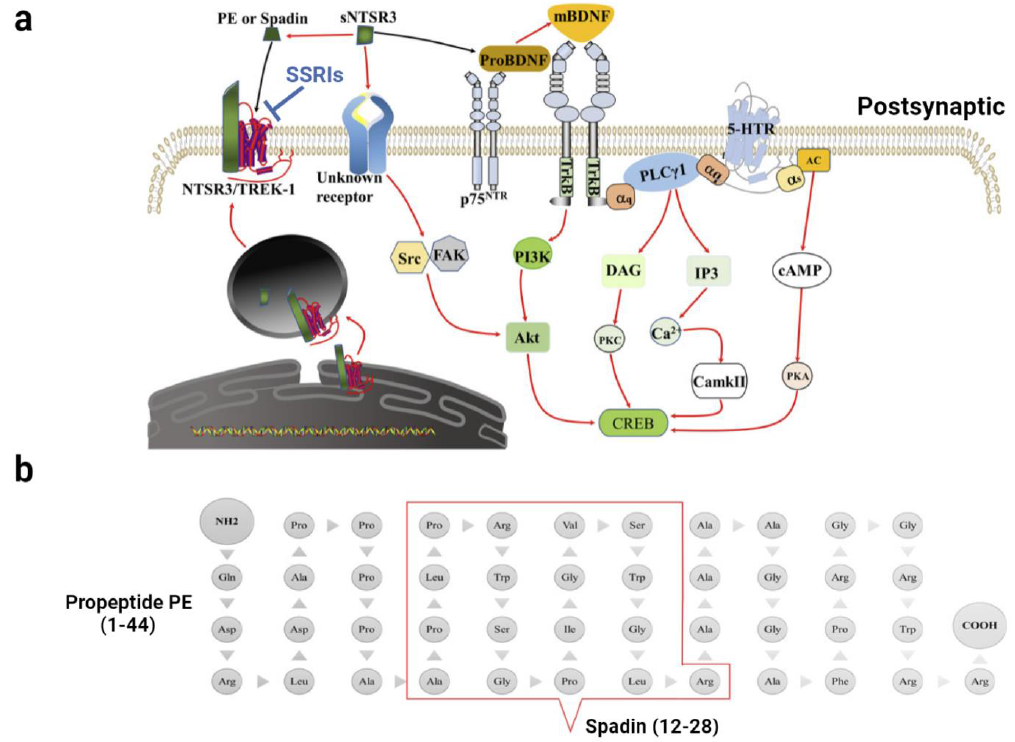
Figure 2. Schematic diagram illustrating the working mechanism of brain-derived peptides. ( a ) The working mechanism and signaling pathways of brain-derived peptides. proBDNF preferentially binds to p75 NTR to drive cell death and synaptic pruning, while mBDNF has a higher affinity for the TrkB receptors to enhance neuronal survival and synaptogenesis. TrkB simultaneously interacts with serotonin receptors. TREK-1 and NTSR3 from the endoplasmic reticulum are co-localized on the cell membrane after shearing maturation. They functionally interact with each other. The extracellular structural domain of NTSR3 is cleaved to form sNTSR3. sNTSR3 can activate downstream signal pathways via unknown receptors (solid red line); meanwhile, it inhibits BDNF maturation (solid black line). sNTSR3 can also be sheared to generate PE or Spadin (solid red line), which blocks the TREK-1 channel (solid black line) and exerts an antidepressant effect. SSRIs are potent blockers of TREK-1 channels. ( b ) Comparison of the peptide sequence of PE and spadin. PE is a propeptide containing 44 amino acids, and spadin has only the peptide sequence at Ala12–Arg28 in PE. Abbreviations: proBDNF, precursor BDNF; mBDNF, mature BDNF; TrkB, tyrosine kinase B; NTSR3, neurotensin receptor 3, or sortilin; sNTSR3, soluble NTSR3; TREK-1, TWIK-related K + Channel 1.